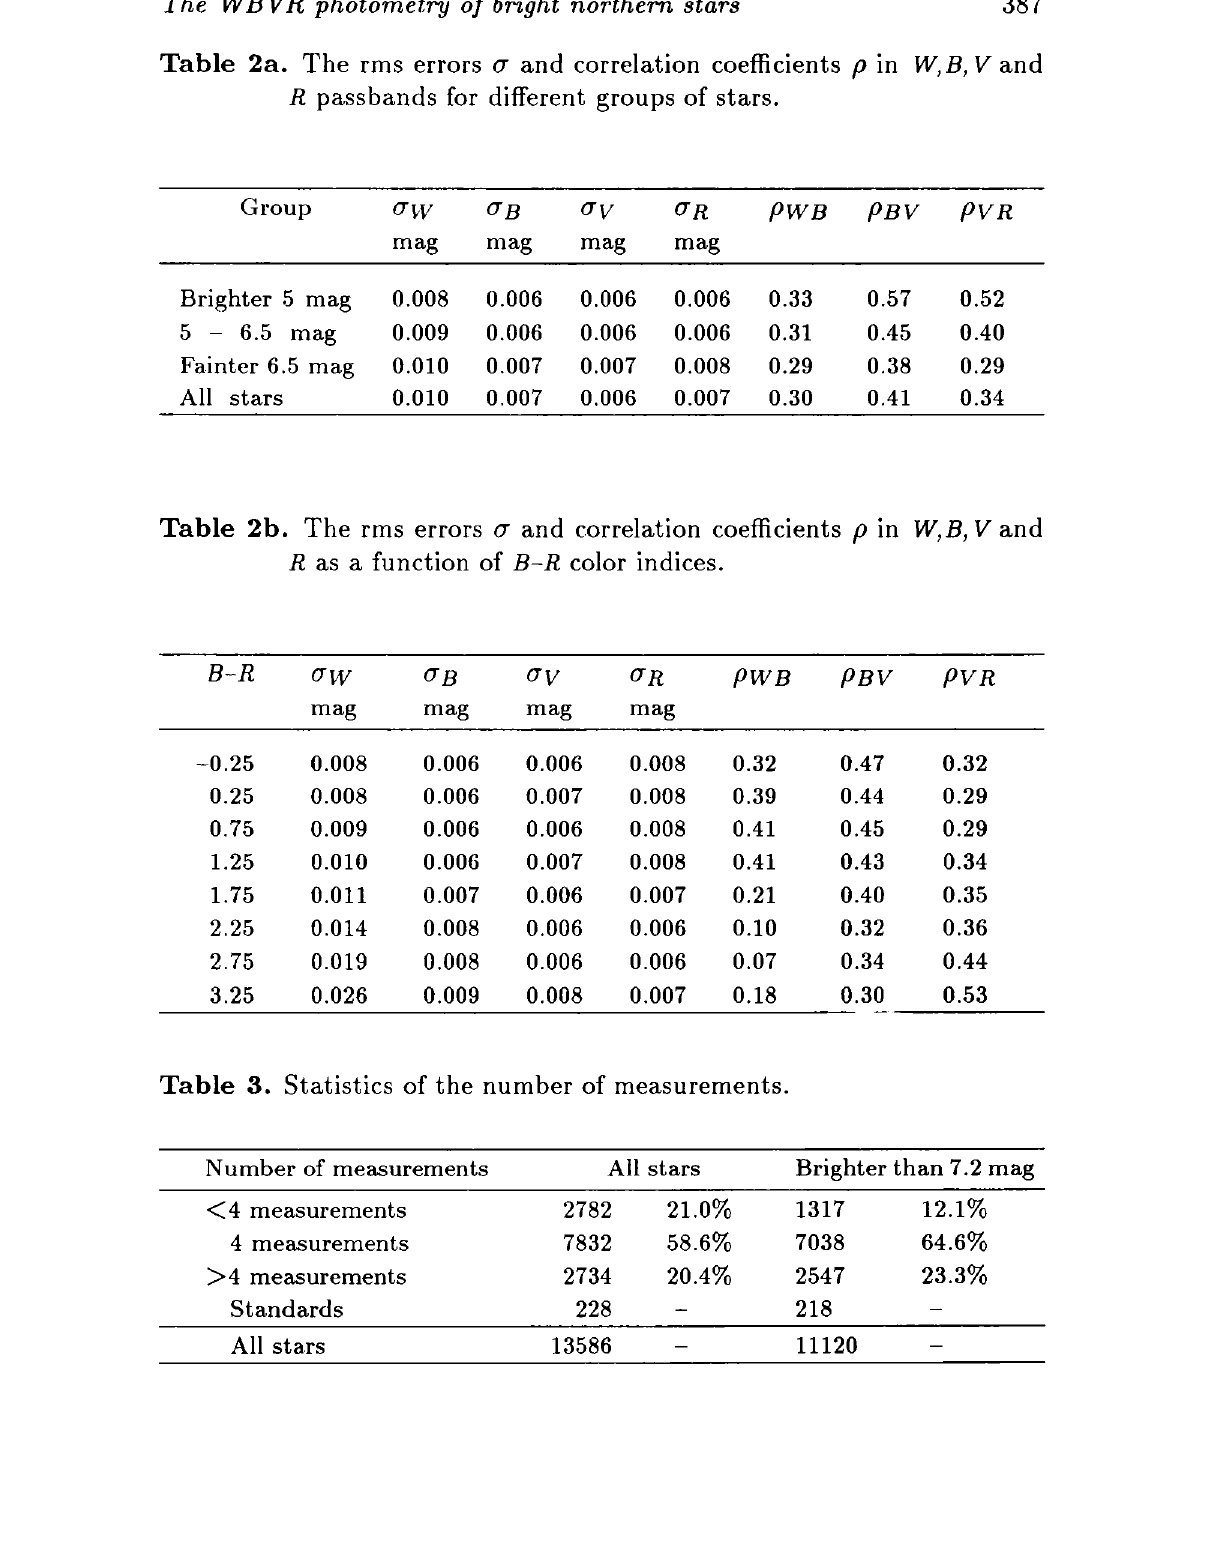
Table 2a. The rms errors a and correlation coefficients p in W,B,V and R passbands for different groups of stars.